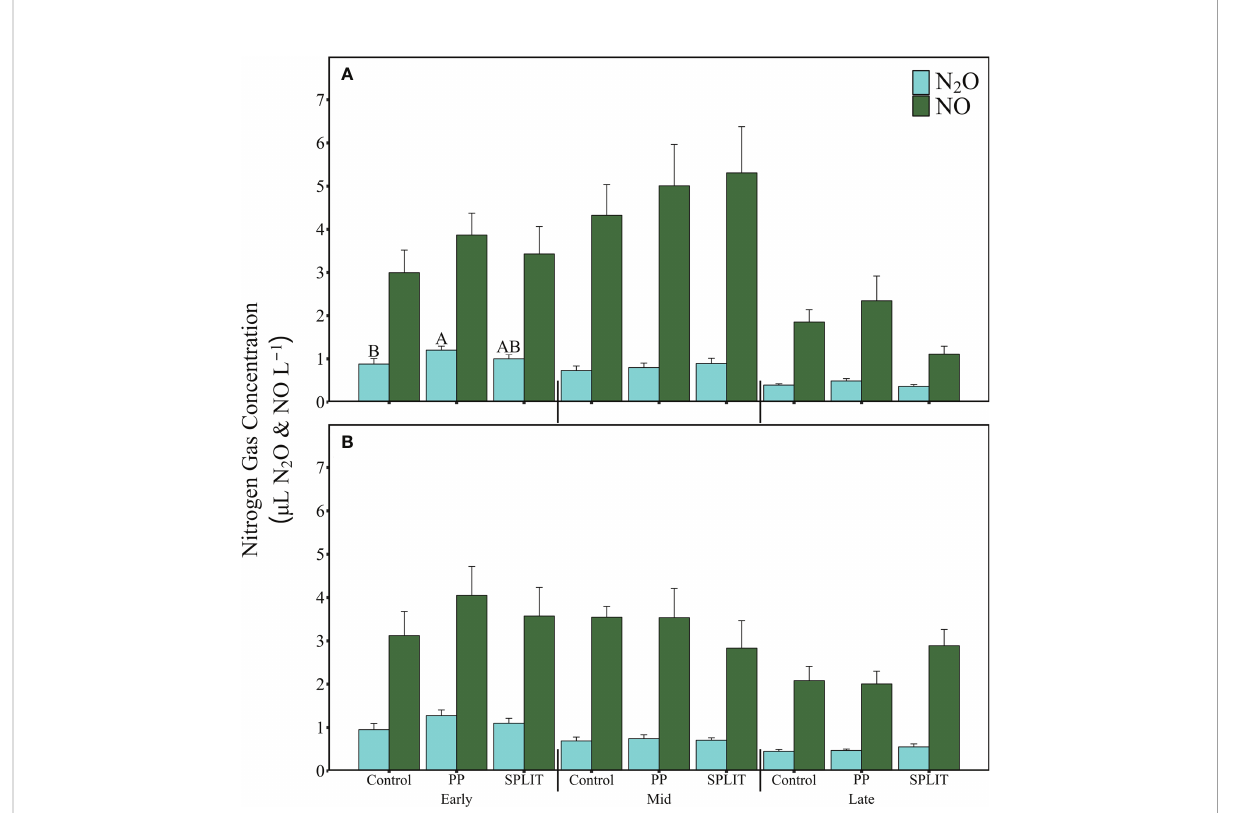
FIGURE 4 Average nitrogen (N) gas concentrations of soil pore-space N gases (N 2 O and NO, µL L -1 ) for N timing treatments at each sampling period. (A) 7.5 cm depth; (B) 15 cm depth. Control, no-added N; PP; 100% pre-plant N fertilizer application; SPLIT 40% pre-plant 60% mid-season application of N fertilizer. LSD letters are different at p< 0.05 within each sampling period and N gas, error bars represent standard error.